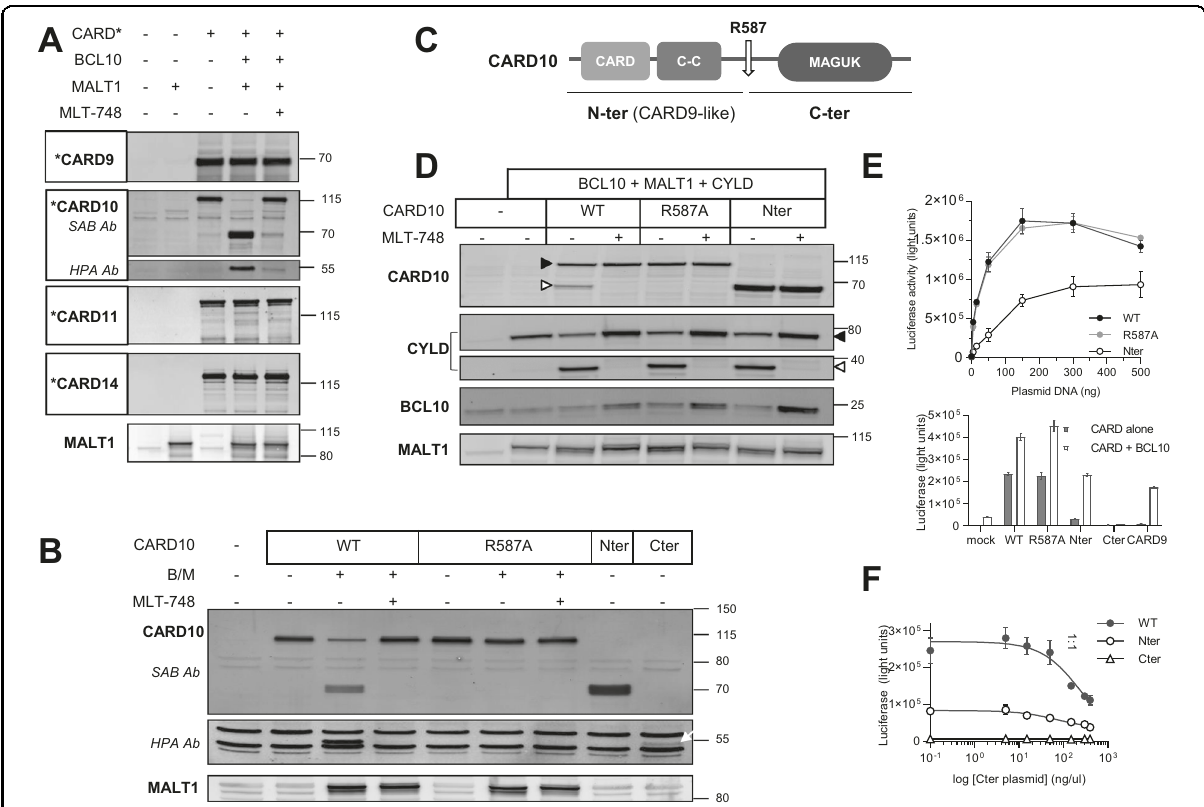
Fig. 1 MALT1 cleaves CARD10 at R587. A CBM reconstitution assay in HEK 293T cells. Plasmids encoding MALT1, BCL10, and CARD* (either CARD9, CARD10, CARD11, or CARD14) were transfected in HEK 293T cells, alone or in combination, ± 1 µM of MLT-748. Western blot showing the obtained band pattern for each CARD protein. This is one of three experiments with similar results. Plasmids encoding GoF mutant forms of CARD11 and CARD14 were also tested, leading to similar results as those shown here with WT forms. B CARD10 constructs were transfected alone or co- transfected with BCL10 and MALT1 (B/M) ± 1 µM of MLT-748. The C-terminal fragment of CARD10 was unstable when overexpressed alone (Fig. 1B, last lane). This is one of three experiments with similar results. C Schematic representation of CARD10 including the protein domains and localization of the MALT1-dependent cleavage site at R587. D The CARD10 constructs were co-transfected with MALT1 and BCL10 together with the MALT1 substrate CYLD, ± 1 µM of MLT-748. Protein expression and post-activation changes were assessed by Western blot. Full-length proteins are annotated with closed triangles and cleaved fragments with open triangles. Cleaved BCL10 is dif fi cult to detect as it is very similar in size to full length BCL10 and because it is rapidly degraded. Full length BCL10 levels are stabilized by addition of MLT-748, which indirectly accounts for BCL10 cleavage, as demonstrated previously 25 . MALT1 self-cleavage band and mono-ubiquitinated species are visible on the membrane, accounting for stimulation in the absence or presence of a MALT1 inhibitor, respectively, as described previously 25 . This is one of three experiments with similar results. E Top, NF- κ B reporter luciferase assay after transfection of increasing concentrations of plasmids encoding either CARD10-WT (1 – 1032) (black fi lled circles), R587A-CARD10 (grey fi lled circles), or CARD10-Nter (1 – 587) (empty circles). Means ± SD of triplicates are shown ( N = 4); bottom, NF- κ B reporter luciferase assay after transfection of CARD10 constructs or CARD9, alone ( fi lled bars) or together with BCL10 (empty bars). Means ± SD of triplicates are shown ( N = 3). F NF- κ B reporter luciferase assay upon transfection of CARD10 WT ( fi lled circles), Nter (empty circles), or mock (empty triangles) together with increasing doses of CARD10-Cter plasmid (588 – 1032); the dotted line indicates the 1:1 dosed vs. tested plasmid ratio. Means ± SD of triplicates are shown ( N =